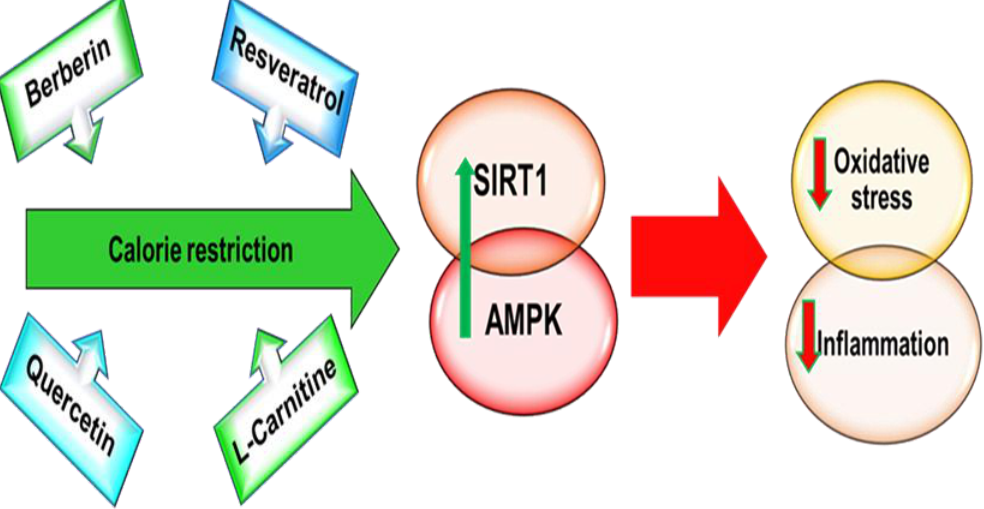
Figure 3. CR-related nutrients. Calorie restriction through AMPK/SIRT activation reduces the risk of developing T2DM and CVD. Berberin, resveratrol, quercetin and L-carnitine are also capable of activating AMPK/SIRT1 and therefore could be used as CR mimetics to preserve a healthy cardiometabolic state.